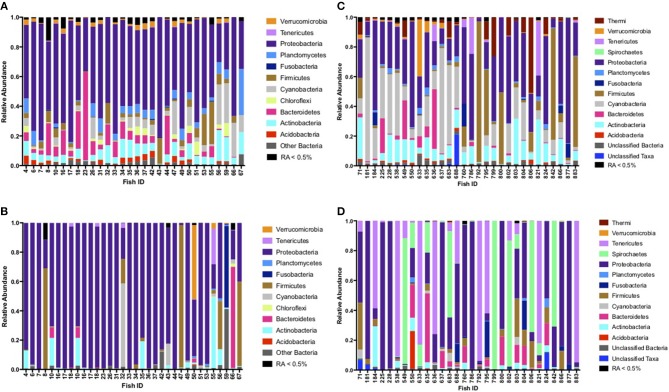
Phyla comparison of skin and intestinal complementary microbiomes for individual fish, shown for samples collected at (A) freshwater sites Port Perry, Swan Lake, and Koka Lake for skin-associated microbiomes, (B) freshwater sites Port Perry, Swan Lake, and Koka Lake for intestine-associated microbiomes, (C) saltwater sites, Back House Point and Legendary River for skin-associated microbiomes, and (D) saltwater sites, Back House Point and Legendary River for intestine-associated microbiomes. Phyla with relative abundances (RA) ≥ 0.5% are shown. Phyla present at RA < 0.5% were pooled together.